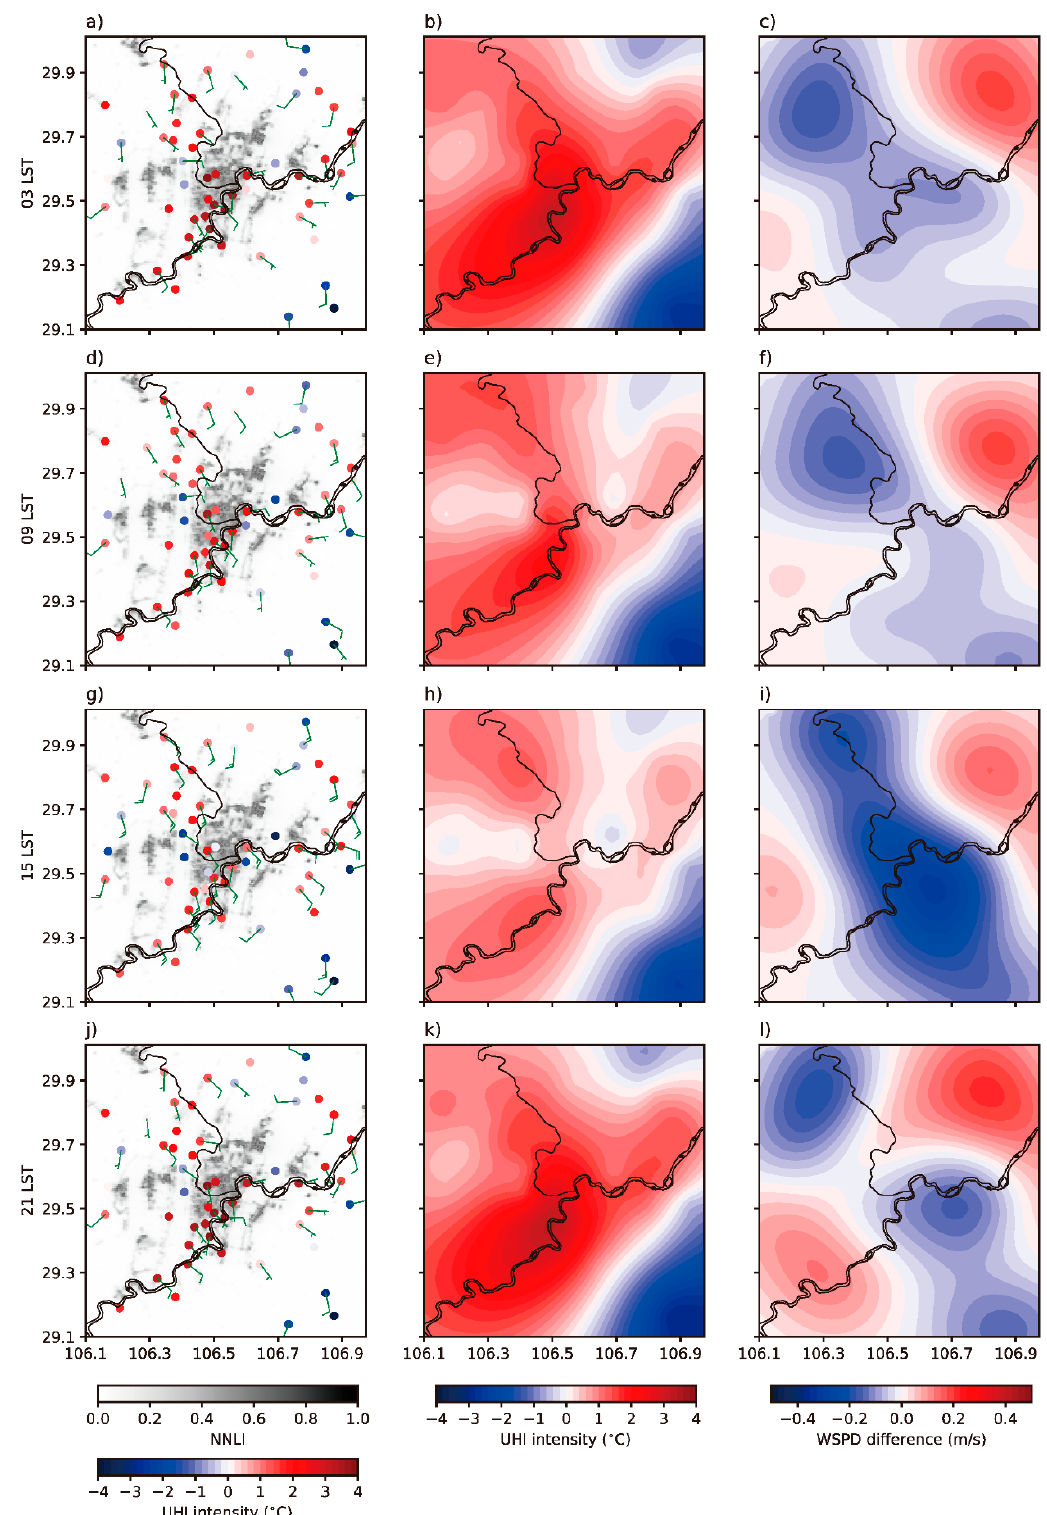
Figure 4. Spatial distribution of mean UHI intensity ( ◦ C) and winds (m/s) at ( a – c ) 03, ( d – f ) 09, ( g – i ) 15, and ( j – l ) 21 local standard time (LST). Left column is scatter plot of UHI intensity (dots) and winds (barbs). A half (full) barb is 0.5 (1.0) m/s; only the winds ≥ 0.5 m/s are shown. Shades are NNLI. Middle (Right) column is the spatial pattern of UHI intensity (wind speed difference) using the kriging interpolation method.